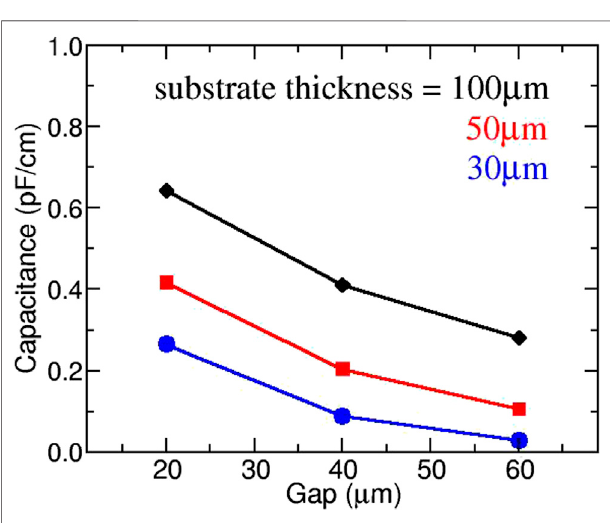
FIGURE9 | TCAD simulations ofthe interpixel capacitance as afunction of the gap between pixels, for different substrate thicknesses.